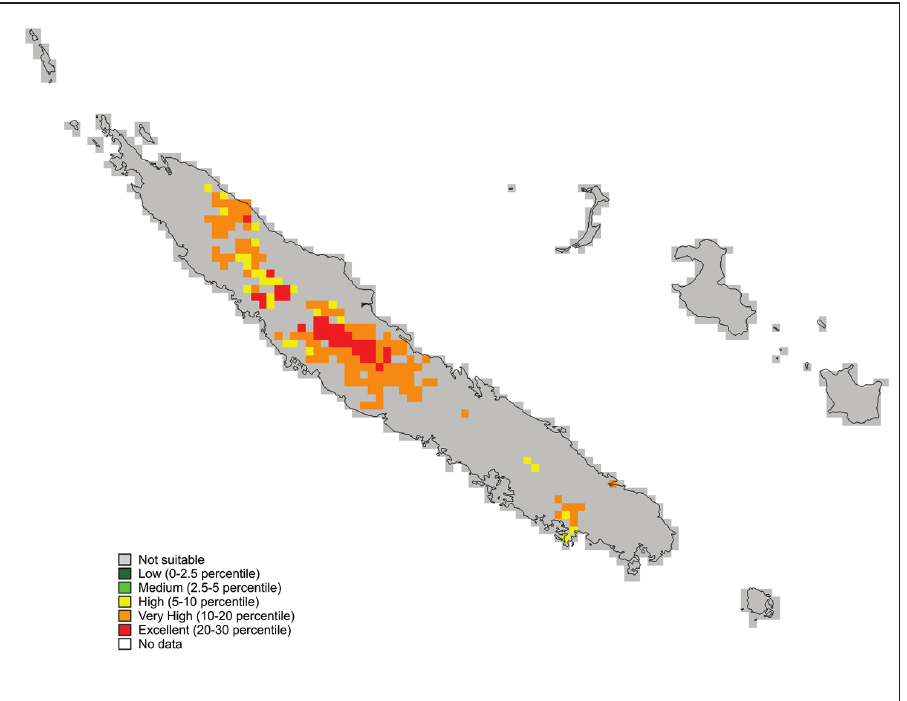
Figure 45. Predicted distribution of Rogmocrypta (14